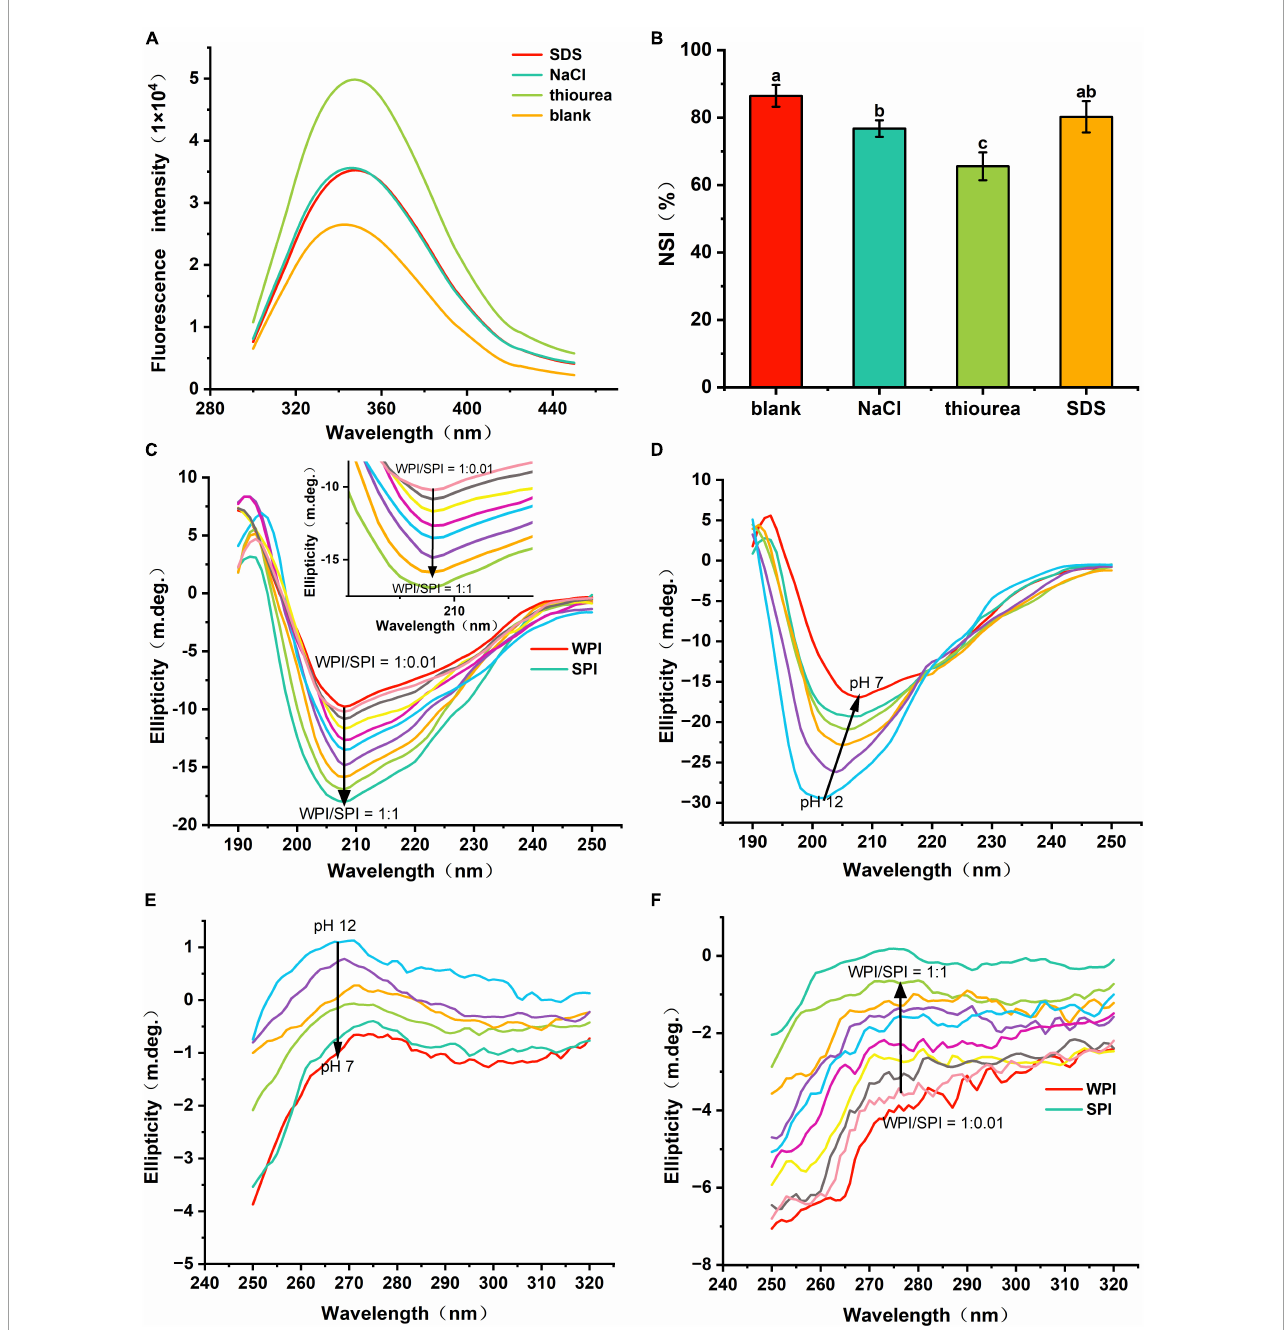
FIGURE6 (A) Fluorescence spectra of composite nanoparticles WPI: SPI = 1:1 (w/w) with bond-disrupting agents added. (B) Nitrogen solubility index (NSI) of WPI with the addition of bond-disrupting agents (10 mM). (C) Far-UV CD spectra of composite nanoparticles with WPI/SPI (w/w) from 1:0.01 to 1:1. (D) Far-UV CD spectra of a representative composite nanoparticles (WPI: SPI = 1:1, w/w) prepared at pH 12, 11, 10, 9, 8, and 7. (E) Near-UV CD spectra of a representative composite nanoparticles (WPI: SPI = 1:1, w/w) prepared at pH 12, 11, 10, 9, 8, and 7. (F) Near-UV CD spectra of composite nanoparticles with WPI: SPI (w/w) from 1:0.01 to